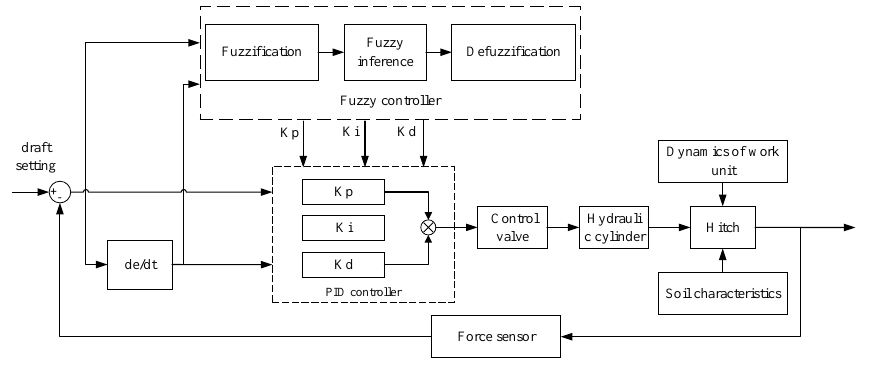
Figure 7. Principle Diagram of the Fuzzy − PID Control Algorithm.